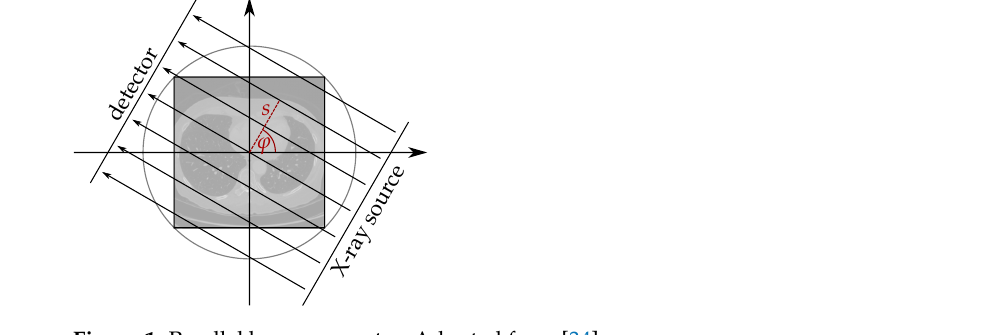
Figure 1. Parallel beam geometry. Adopted from [34]. Table 1. Settings of the low-dose parallel beam computed tomography (LoDoPaB-CT) and Apple CT